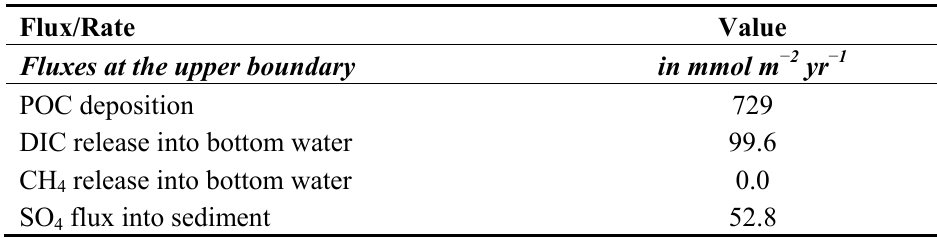
Table 3. Fluxes at the upper boundary of the model column, depth-integrated rates and carbon inventories calculated in the reference